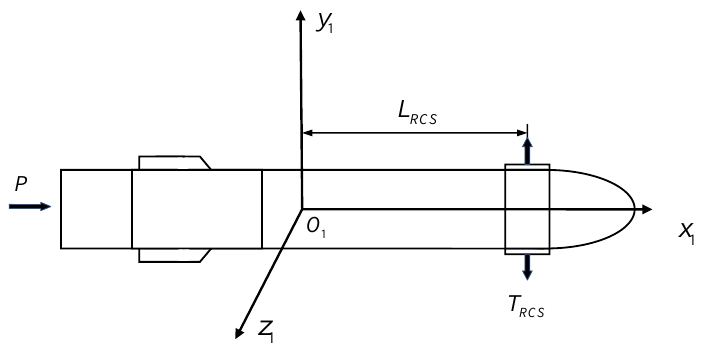
Figure 1. Sketch map of the agile missile.